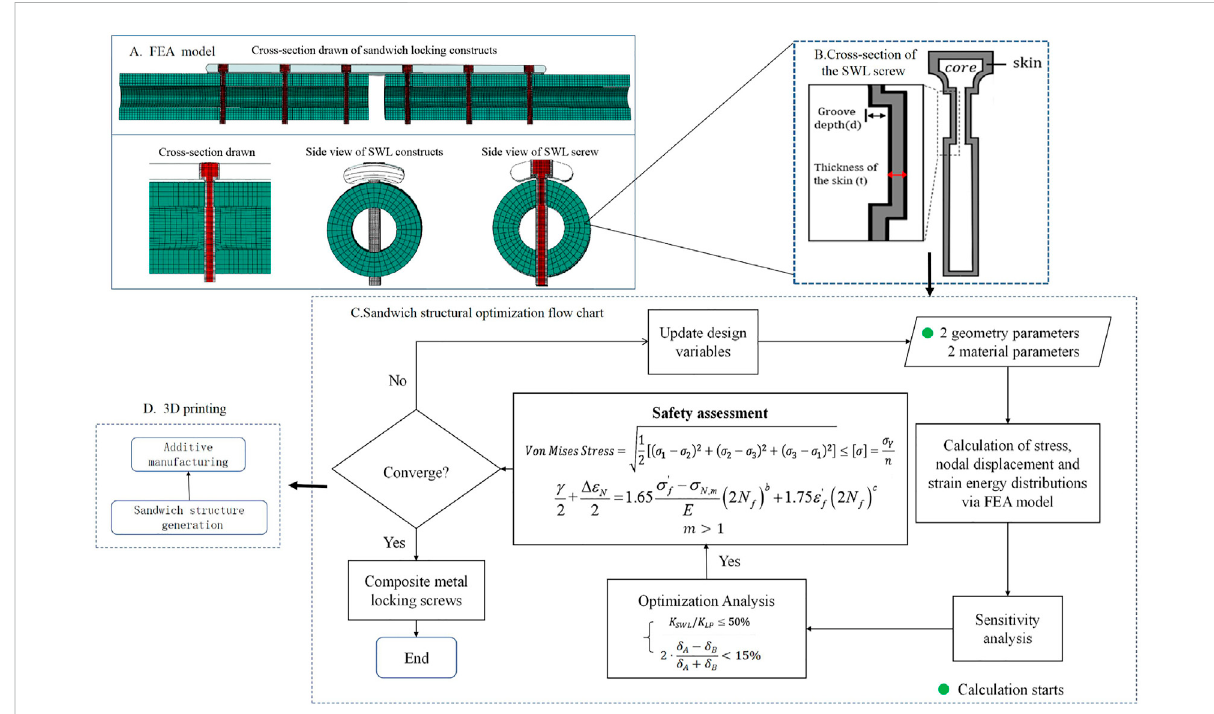
FIGURE 1 Steps for optimizing a sandwich composite metal locking screw. (A) Section view of optimized fi nite element model of sandwich locking (SWL) screw,andstructureschematicdiagram. (B) Schematicdiagramofacross-sectionofacompositemetalscrewwithasandwichstructure.Thecoreis a sandwich structure, the skin is the titanium layer structure on the surface of the screw, d is the depth of the groove of the screw at the proximal cortex, and t is the thickness of the protective structure of the surface titanium layer. (C) Flow chart of sandwich locking screw optimization for each design parameter, (D) Sandwich structure generation and additive manufacturing of the